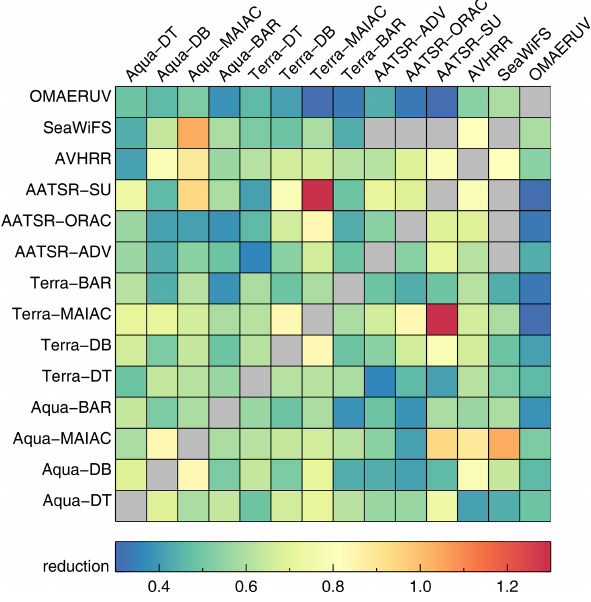
Figure 18. The ratio of typical difference (mean of sign-less dif- ference) for spatial coverage at 90%–100% to 0%–10%. Products were collocated pair-wise within 1h.